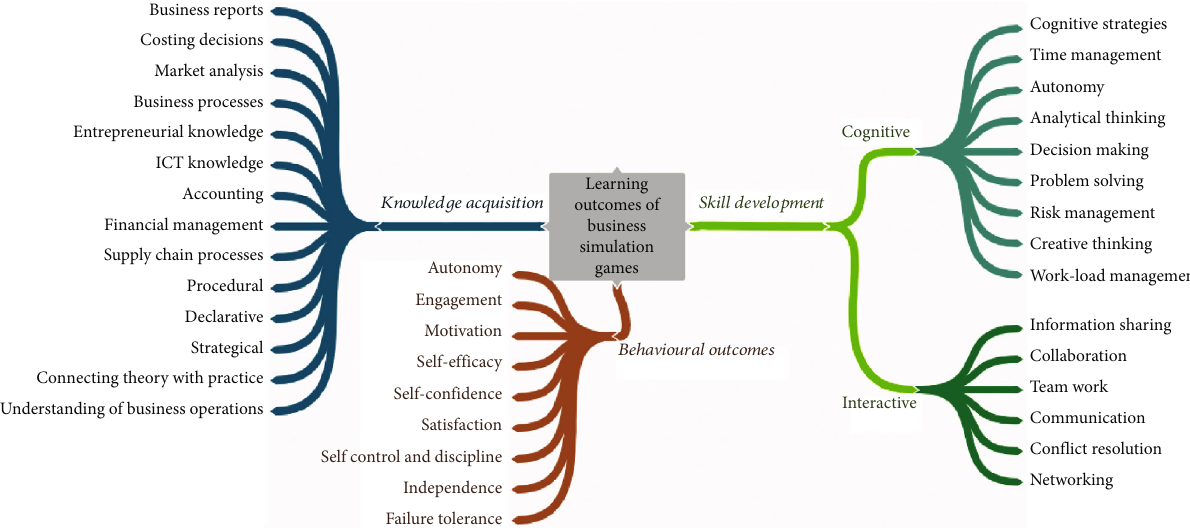
Figure 12: Learning outcomes of